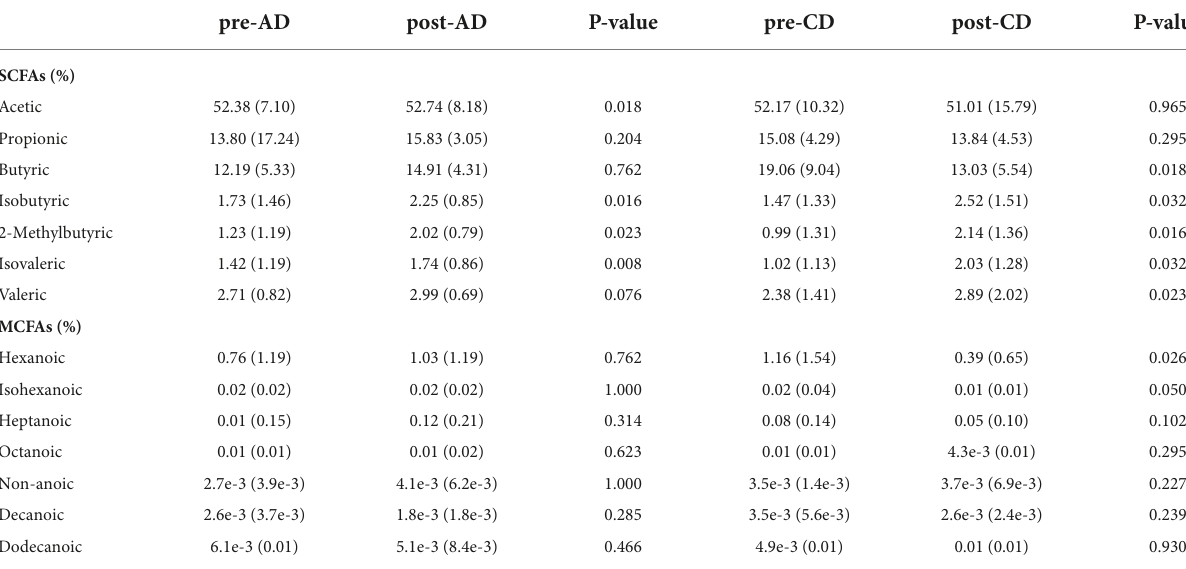
TABLE 1 SCFAs and MCFAs variation according to the dietary interventions. pre-AD post-AD P-value pre-CD post-CD